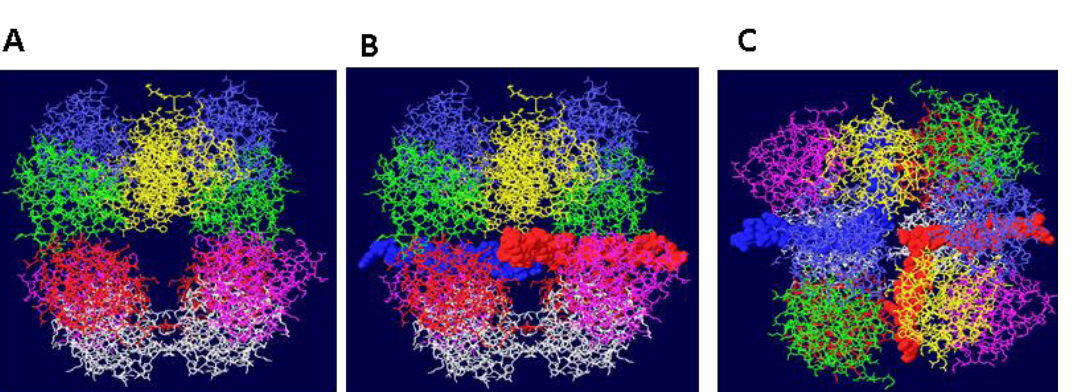
Figure 2. Threading of SSDNA through the OBD DH. (A ) The structure shown in 1A has been rotated by 90 degrees to show the two side holes of this DH structure. In ( B ), the same representation is shown with single stranded DNA. One strand (red) goes through the central channel of the OBD hexamer on the right and out through the side hole towards the viewer. The other strand (blue) goes through the other OBD hexamer and exits towards the back. ( C ) The structure shown in 2B has been rotated by 90 degrees to show the DNA emerging at the bottom and top.